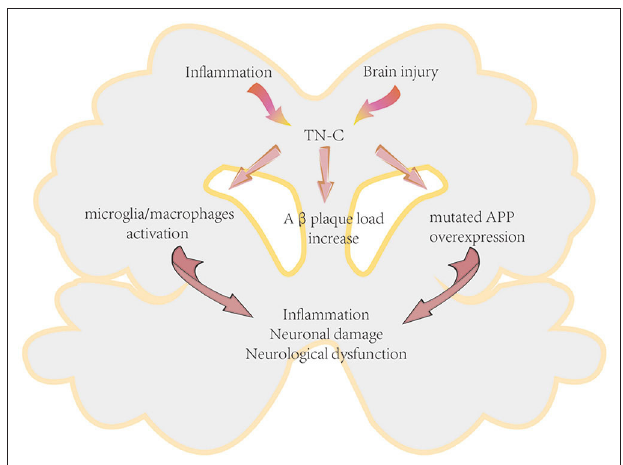
FIGURE 5 | Proposed mechanism of TN-C in the pathogenesis of Alzheimer’s disease. APP, amyloid precursor